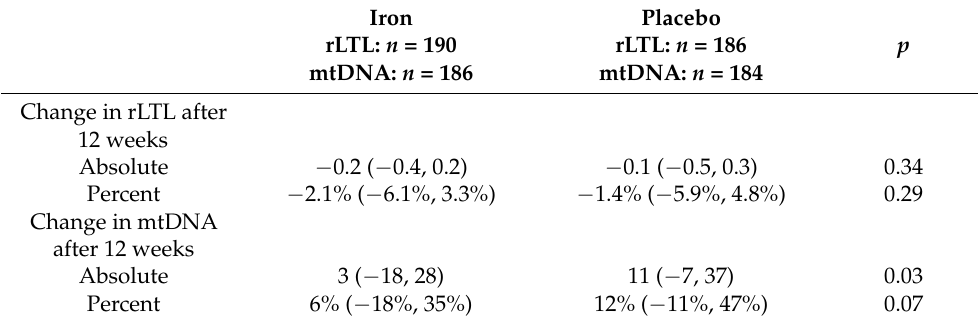
Table 3. Unadjusted change in rLTL and mtDNA content after 12 weeks 1,2